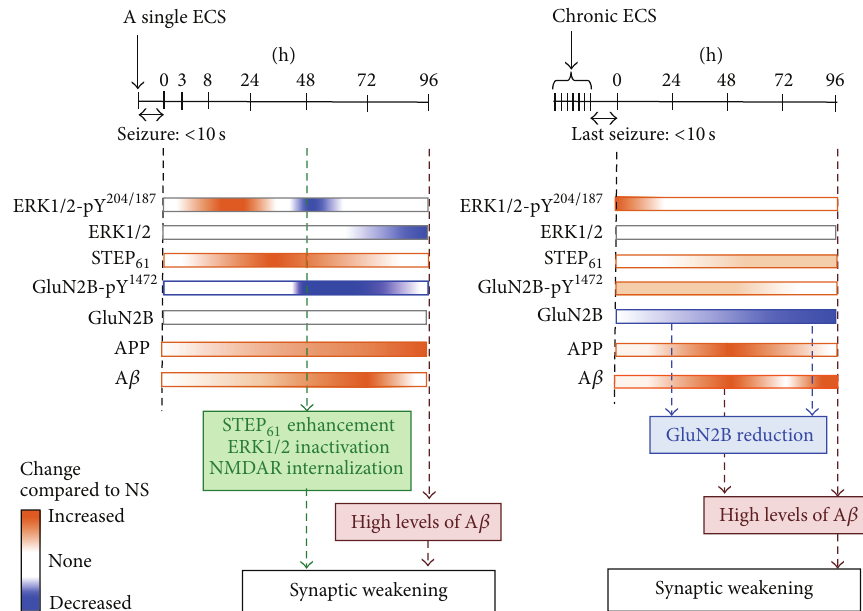
Figure 6: Model by which seizure-induced changes in A 𝛽 , STEP 61 , and Tyr-phosphorylation of STEP 61 lead to synaptic weakening in the hippocampus. A single ECS increases STEP 61 expression and decreases Tyr-phosphorylation of NMDAR subunit GluN2B and ERK1/2 in the hippocampus at 48h time point, leading to synaptic weakening via NMDAR internalization and ERK1/2 inactivation. A delayed decrease in ERK1/2 expression as well as a delayed enhancement of APP and A 𝛽 expression at 72–96 h following a single ECS maintains this synaptic weakening. Chronic ECS-induced increase in APP expression and A 𝛽 production as well as persistent decrease in total GluN2B level leads to synaptic